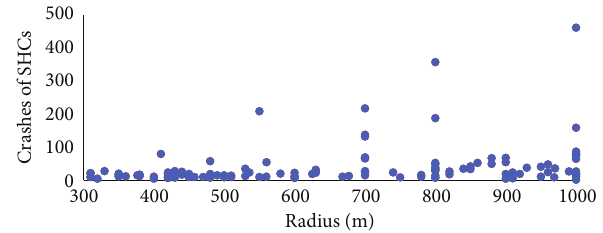
Figure 2: Crashes of 117 SHCs in survey data (Guangdong, 2008– 2012).